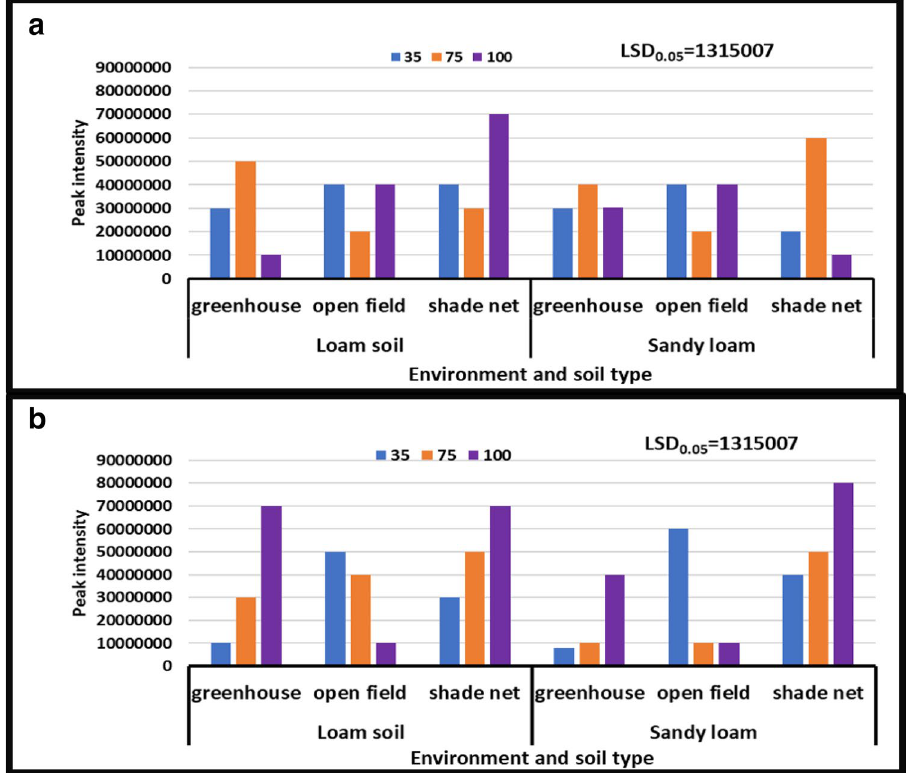
Figure 2. Treatment interaction effect on asparagine of African horned cucumber fruit. ( a ) Means treatment interaction of irrigation water regimes and soil types at different growing environments during the 2017/18 season; ( b ) means treatment interaction of water stress levels and soil types at different growing environments during the 2018/19 season. Values are average over treatment; 35 means severe water stress; 75 means moderate water stress; 100 means no water stress. Peak intensity showing LCMS-8040 triple quadrupole mass spectrometer intensities which represent the quantity of metabolites varying with treatments. LSD 0.05 is the least significant difference of